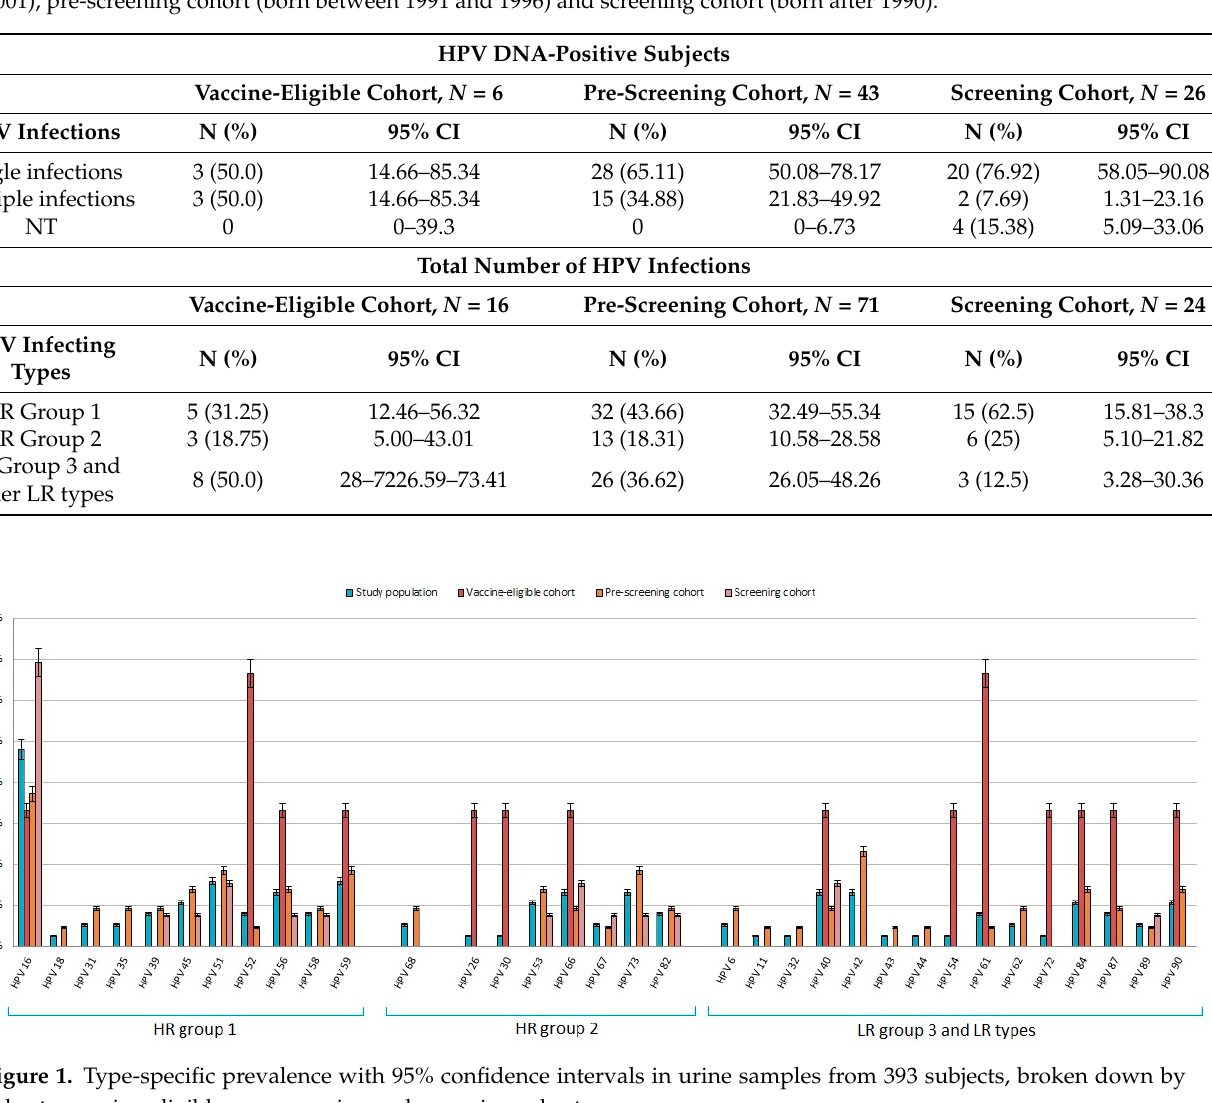
Table 3. HPV infections and HPV infecting types, broken down by cohorts: vaccine-eligible cohort (born between 1997 and 2001), pre-screening cohort (born between 1991 and 1996) and screening cohort (born after 1990).